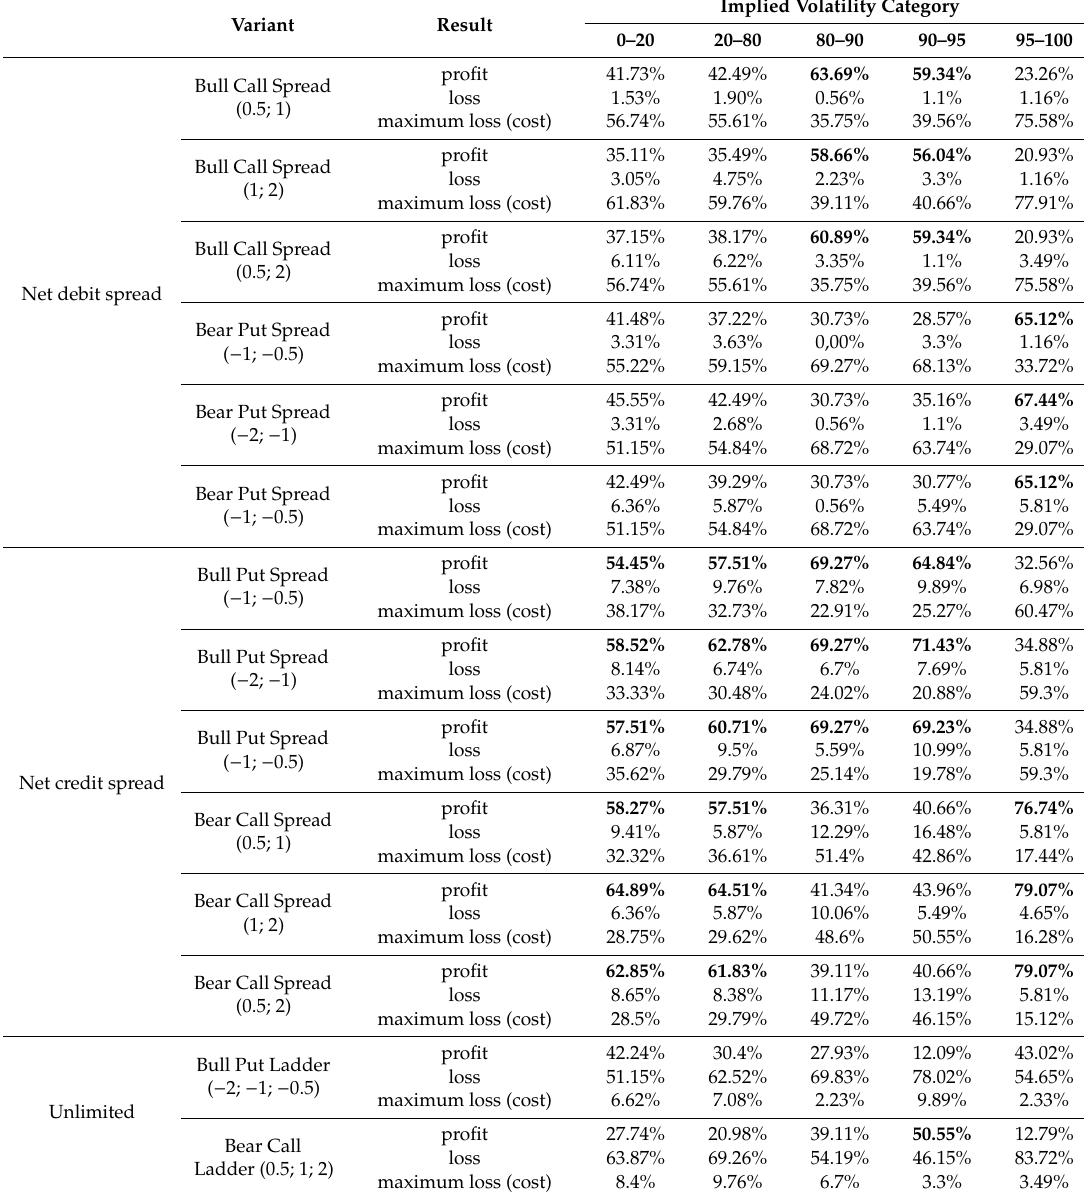
Table 5. The frequency of occurrence of the three di ff erent states related to the using